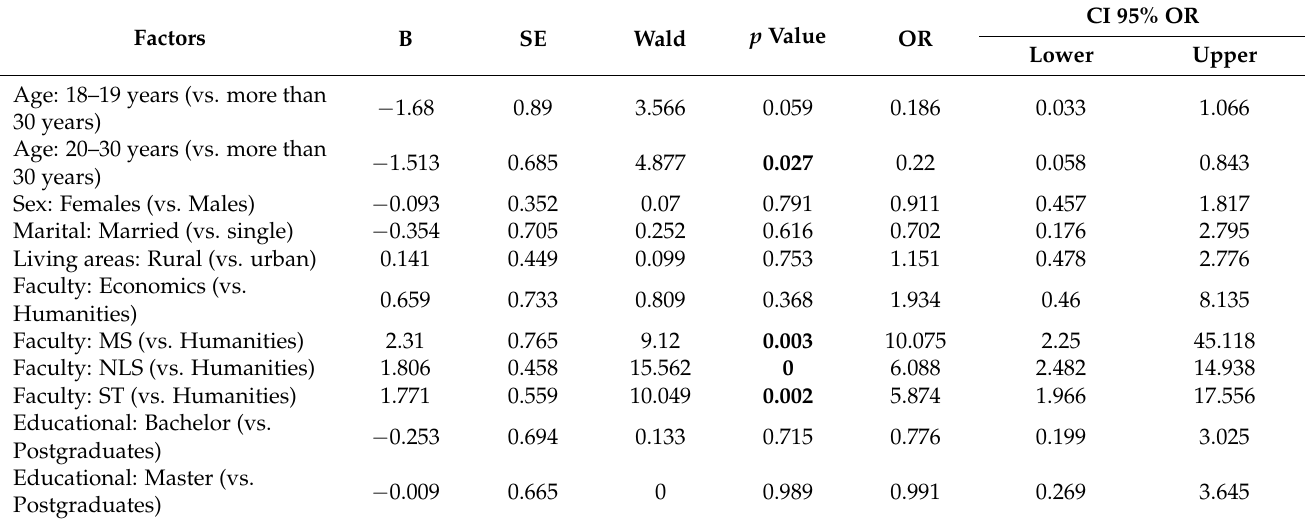
Table 5. Regression analysis of the demographic factors associated with high levels of